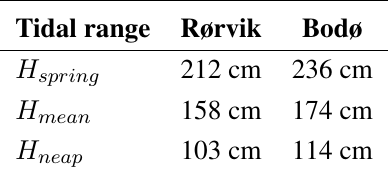
Table 2. Tidal level characteristics from the Rørvik and Bodø water level measuring